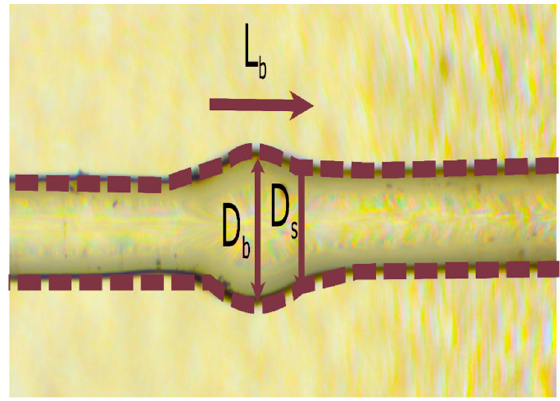
Figure 3. A microbo tt le resonator formed by soften-and-compress technique with a bo tt le diameter Figure 3. A microbottle resonator formed by soften-and-compress technique with a bottle diameter ( D b ), ( 𝐷 𝑏 ), stem diameter ( 𝐷𝑠 ), and the bo tt le length(L b ). stem diameter ( Ds ), and the bottle length (L b